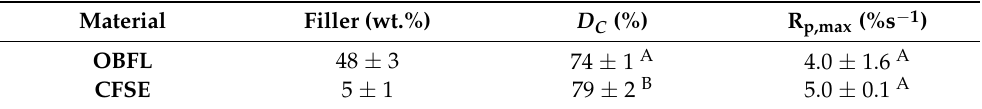
Table 5. Means and standard deviation of filler load and polymerisation kinetics: D C (%) = final extrapolated degree of conversion and Rp (%s − 1 ) is the maximum rate of reaction ( n = 3). Different capital letters in the same column that indicate difference is statistically significant at ( p < 0.05). D C